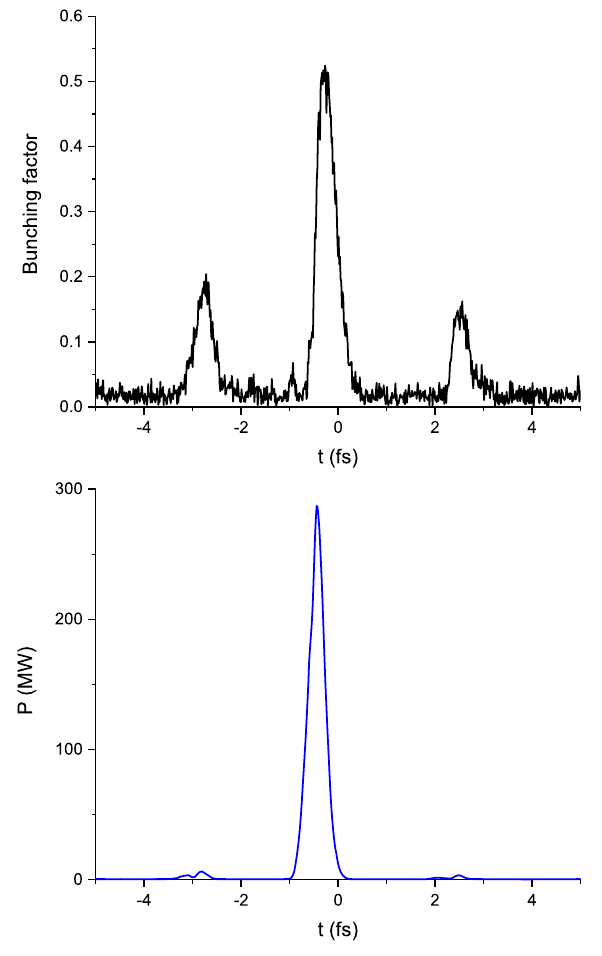
FIG. 3. Bunching factor at the entrance to the radiator (upper plot) and power at its exit (lower plot) for a single shot. Bunch head is on the left side. FIG. 4. Spectrum of the radiation pulse presented on Fig.